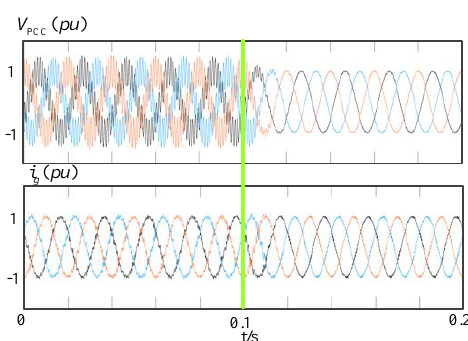
Figure 10. The proposed control strategy for the 1 kW VSC system with different parameters.